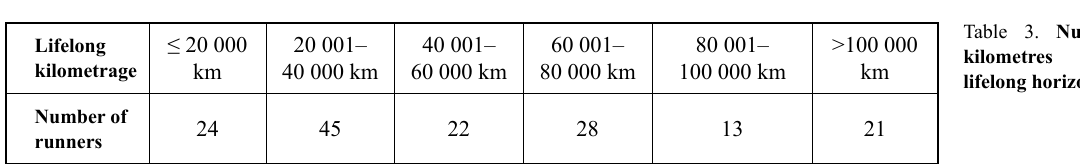
Table 3. Number of kilometres in the lifelong